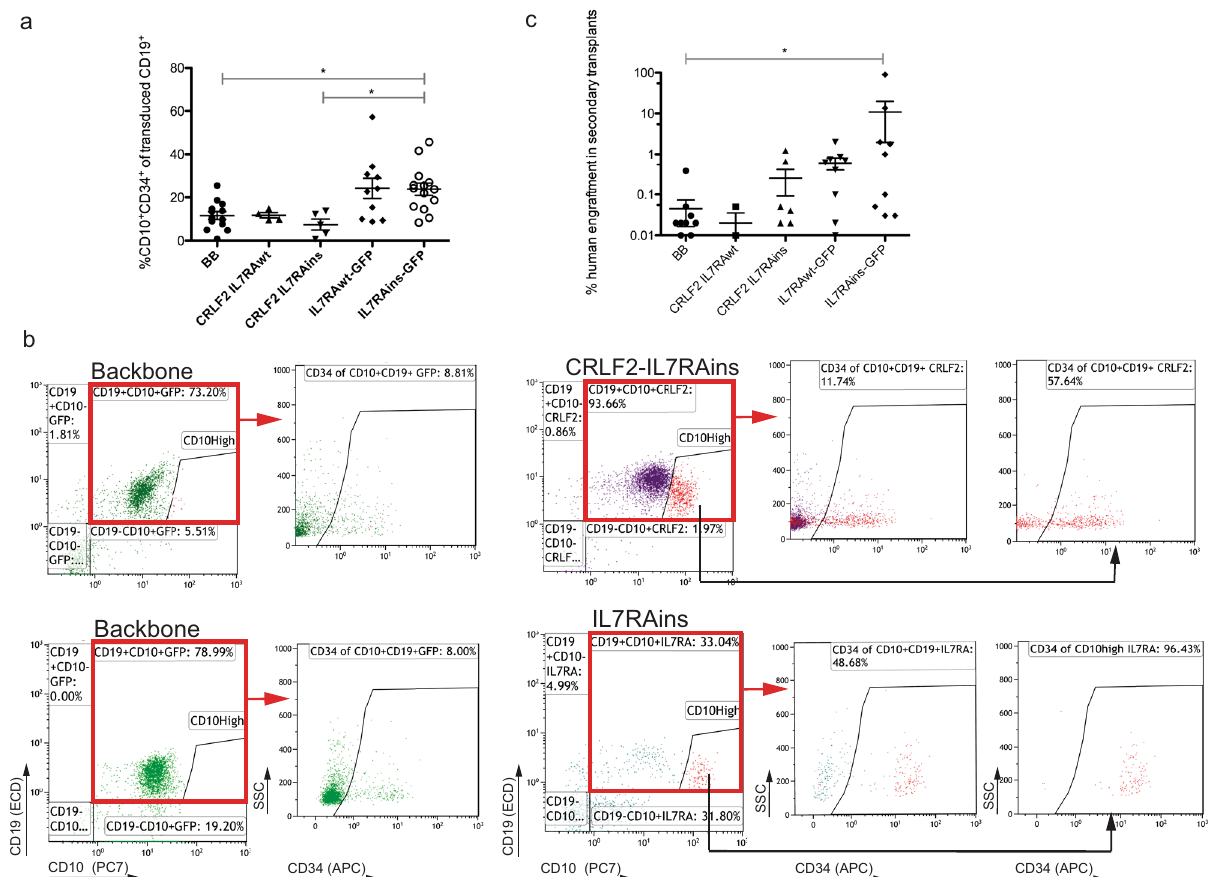
Fig. 2 Enhanced CD34 + CD10 + expression and self-renewal of IL7RA-activated cells. a Relative CD10 + CD34 + population of engrafted transduced human CD19 + cells in BM (BB n = 11, CRLF2-IL7RAwt n = 4, CRLF2-IL7RAins n = 5, IL7RAwt-GFP n = 10, IL7RAins-GFP n = 14). b Flow cytometry immunophenotyping of engrafted backbone and CRLF2-IL7RAins or IL7RAins-transduced cells. Samples in the same row are from the same CB batch. Arrows indicate that the gated population was analyzed in the following scatters. Gating strategy for ( a ), ( b ) in Supplementary Fig. 3. c Percentage of human cells in BM of secondary recipient mice that were transplanted with BM cells of primary engrafted mice (BB n = 13, CRLF2-IL7RAwt n = 3, CRLF2- IL7RAins n = 8, IL7RAwt-GFP n = 9, IL7RAins-GFP n = 10 — six points with a value of zero were out of the logarithmic graph range, but were included in the mean and SEM calculations). a , c Dot plots depict sample scatter with mean + / − SEM. Each dot represents the analysis of a single mouse. Gray linkers indicate a statistically signi fi cant difference (* P < 0.05) between groups. Statistical analyses were performed using Kruskal – Wallis nonparametric one-way ANOVA test with Dunn ’ s post hoc analysis. Source data are provided as a Source Data fi